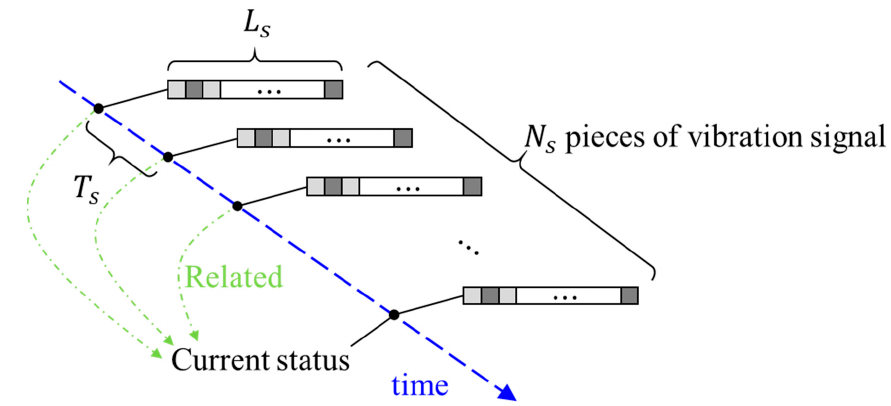
Figure 6. Illustration of time series inputs for 1-D CNN.